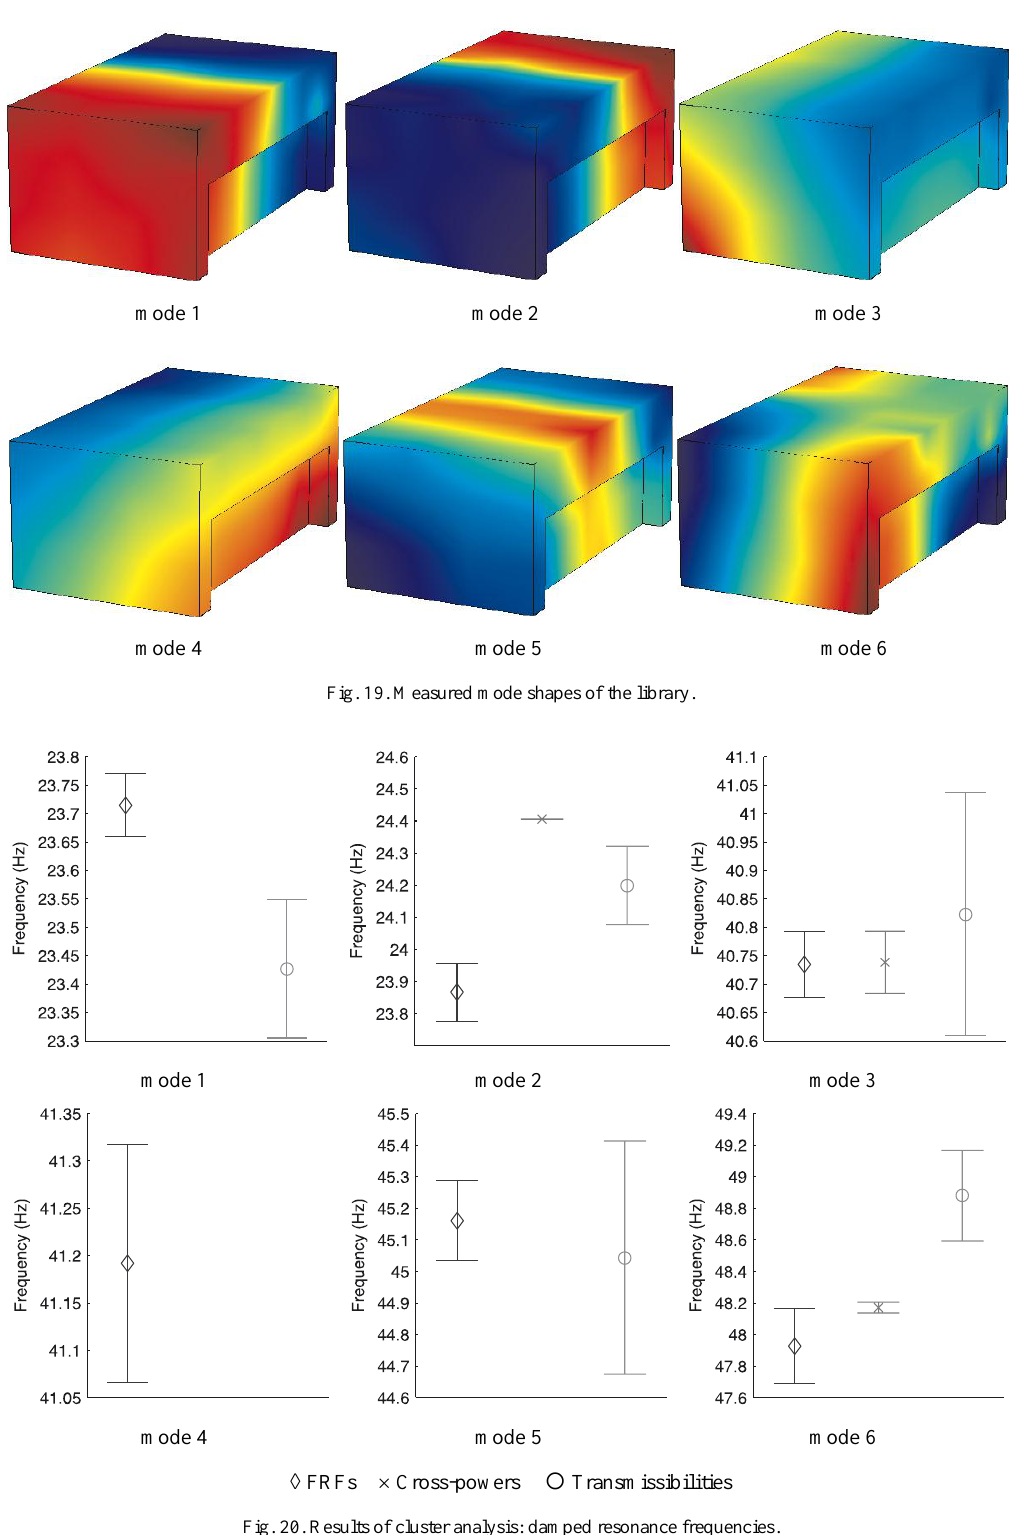
Fig. 20. Results of cluster analysis: damped resonance